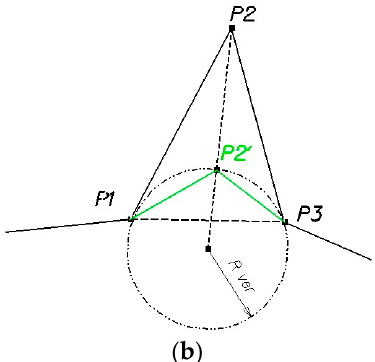
Figure 5. ( a ) Block diagram of the algorithm. ( b ) Smoothing the vector line.